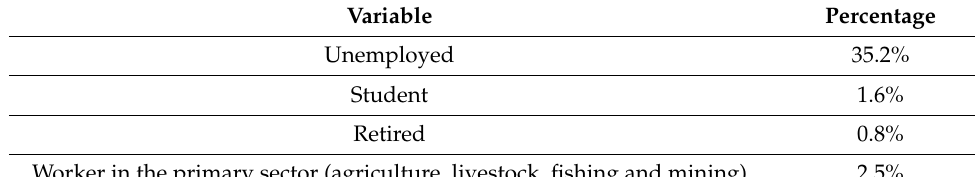
Table 1. Cont. Variable Percentage Unemployed 35.2% Student 1.6% Retired 0.8% Worker in the primary sector (agriculture, livestock, fishing and mining) 2.5% Secondary sector worker (crafts, industry, construction and energy production) Tertiary sector worker (commerce, communications, finance,